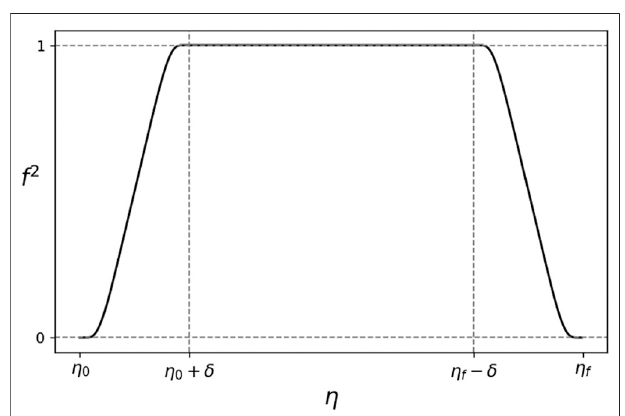
FIGURE 1 | The smooth step function de fi ned in (15) , represented in terms of its parameters: initial and fi nal points, η i and η f respectively, and δ , which controls the ramping